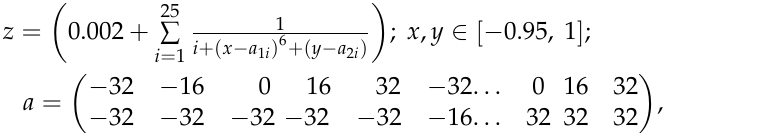
Figure 29. Polynomial regression of relative rank to relative error on X 4 .